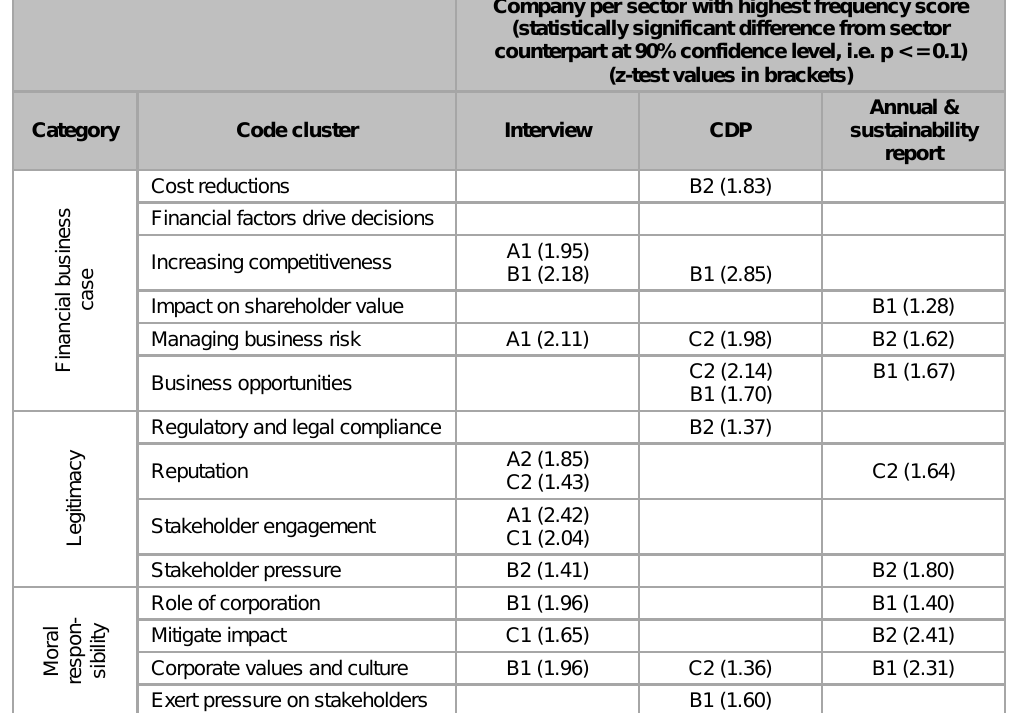
Statistically significant differences in cluster frequency proportions per sector Company per sector with highest frequency score (statistically significant difference from